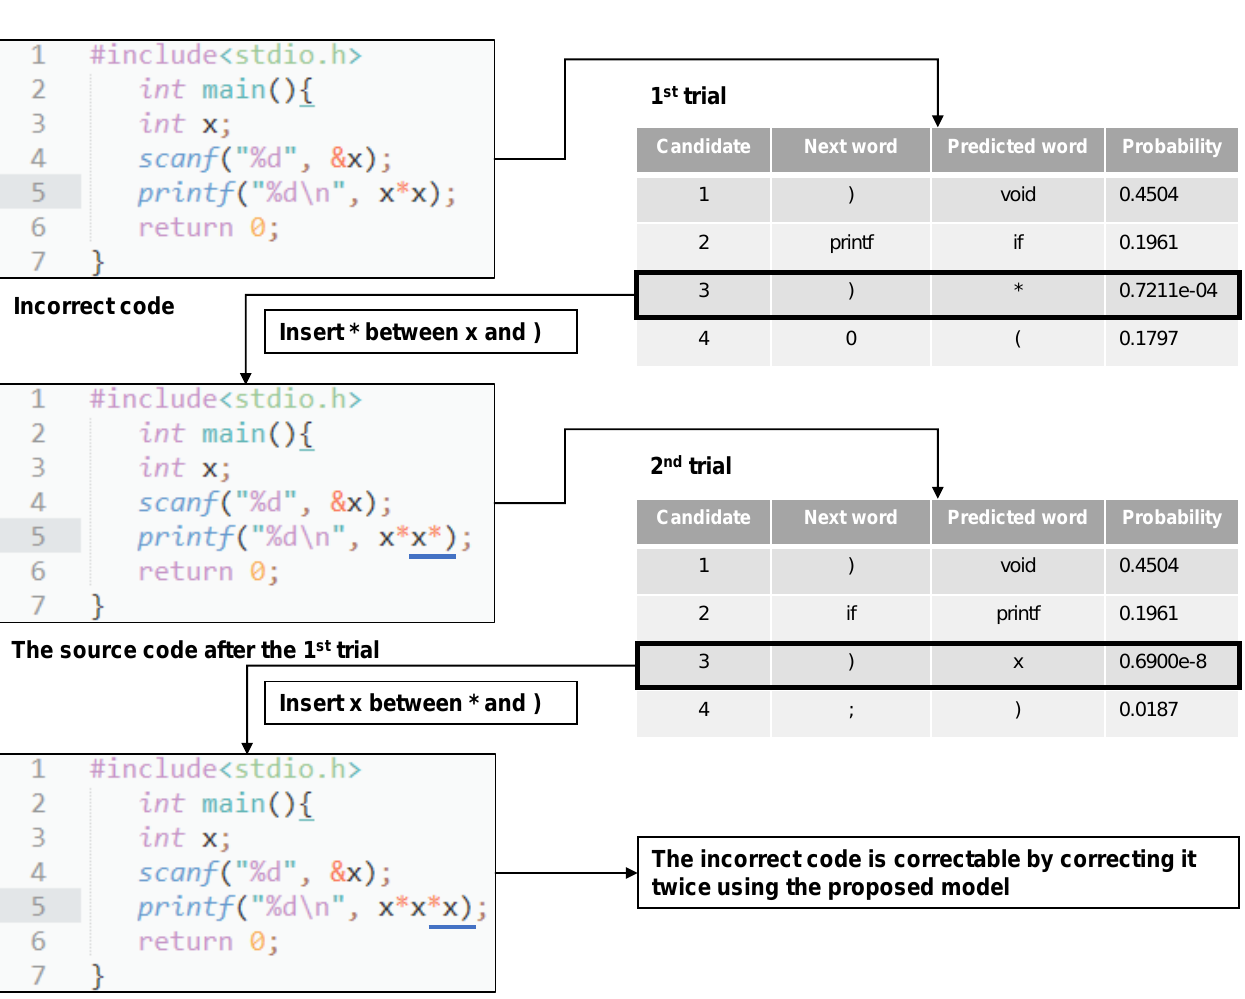
Figure 4. Example of logic error correction using proposed